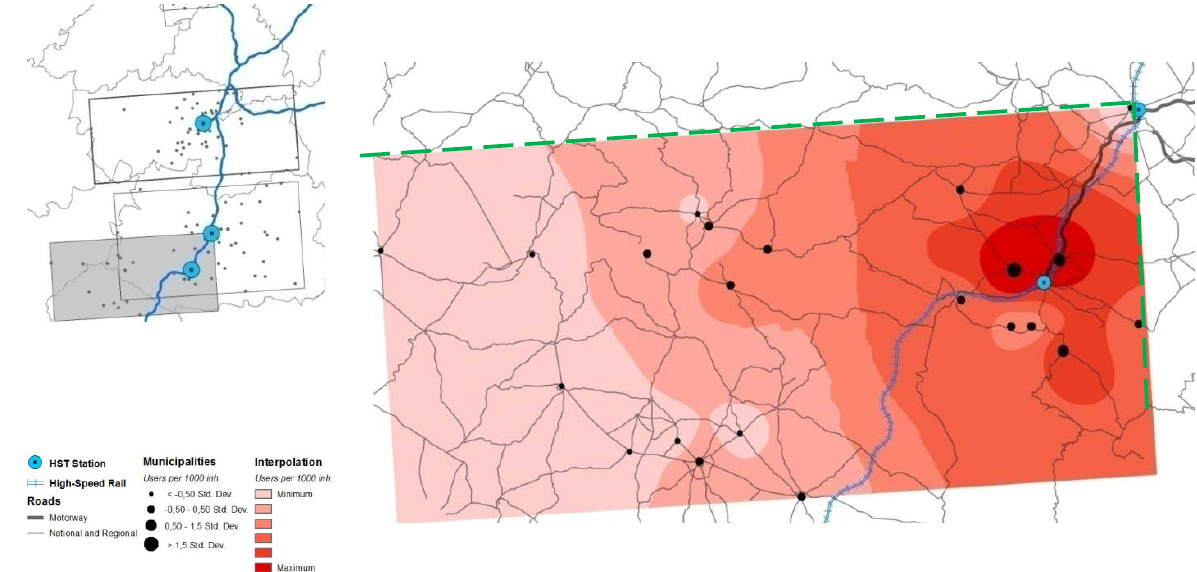
Figure 10. Puertollano’s catchment